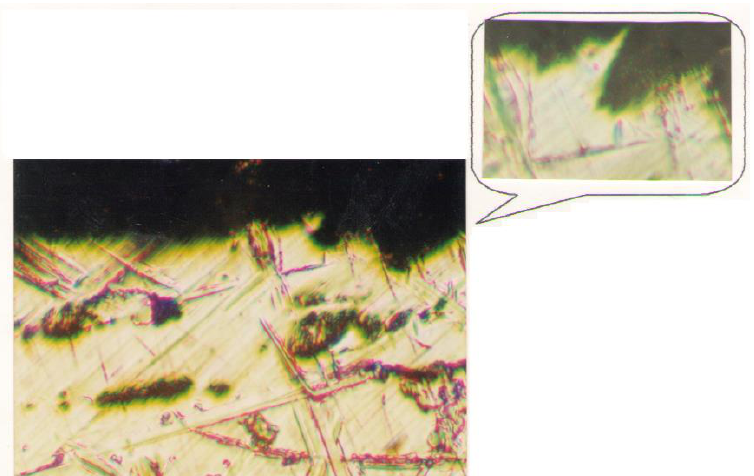
Figure 11. View manufactured surface with a chip root (×100); (a portion of the ×500 scale view is shown at the top).